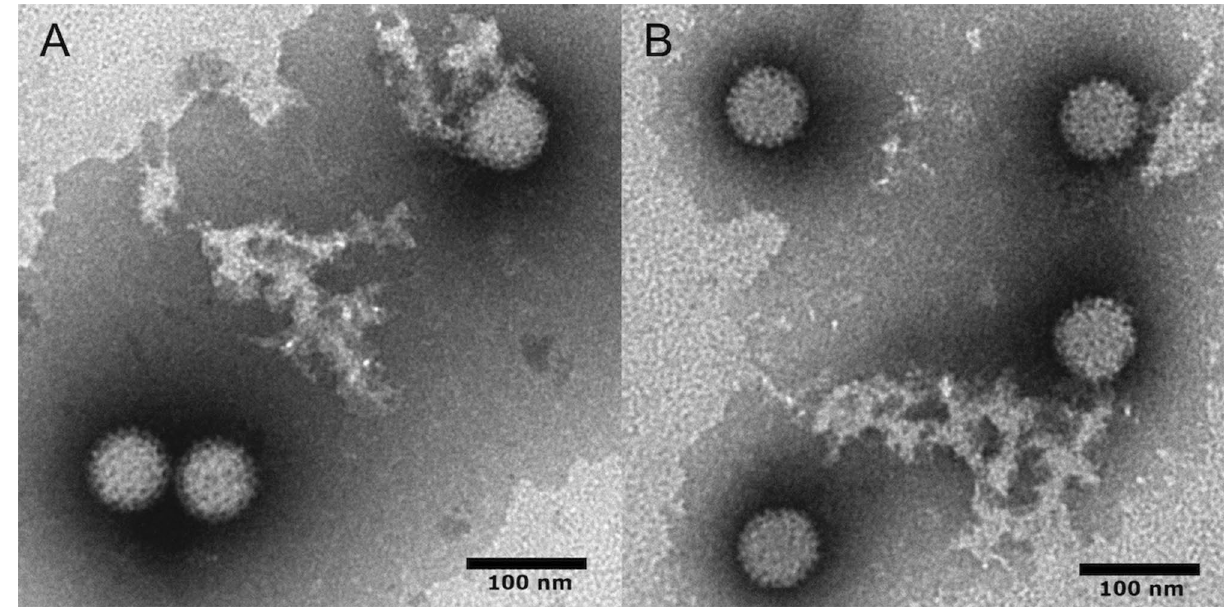
Figure 1. Identification of novel MRV isolates. Electron microscopic observation of novel MRV isolates, ( A ) THK0325 and ( B ) THK0617. Negatively stained virions showing icosahedral particles with a diameter of 60–70 nm. Bar = 100